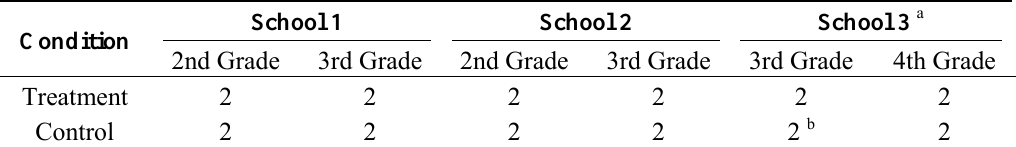
Table 1. Final number of participating classrooms by grade per